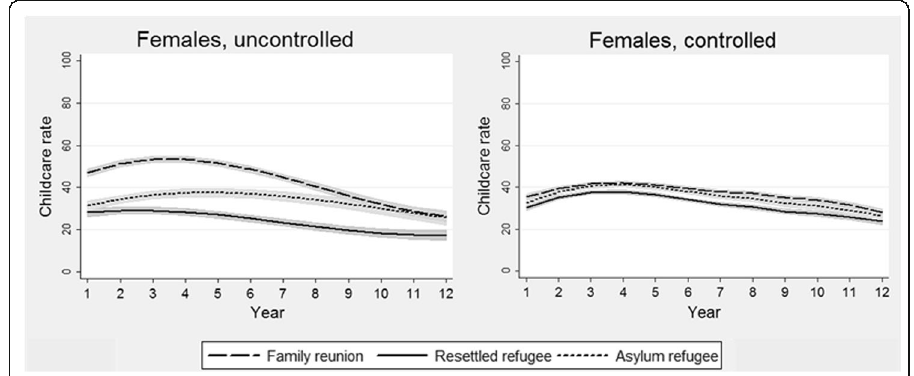
Fig. 4 The predicted childcare rates, i.e. receipt of parental and cash-for-care benefits by admission category and duration of stay among females aged 25 – 60. Notes: Robust 95% confidence intervals are shown. Controls are held at means in particular year. See Table 3 in Appendix for regression